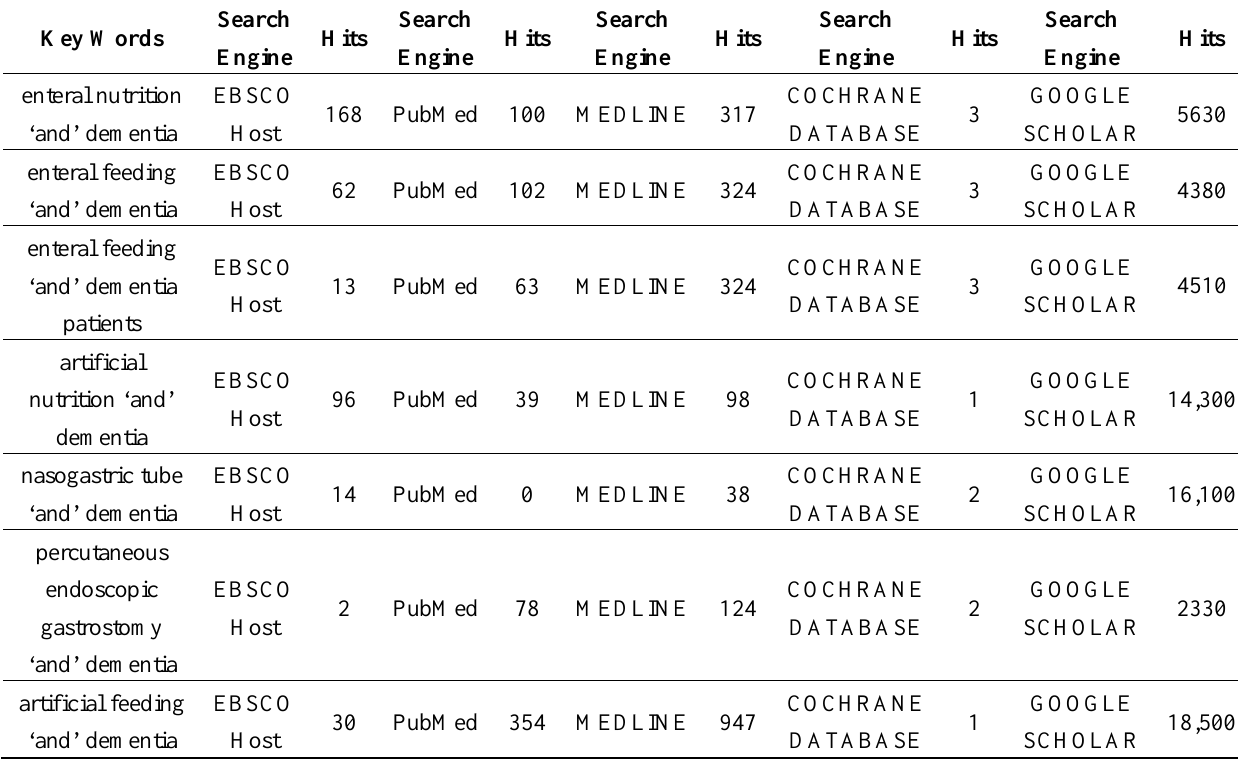
Table 1. Literature Search